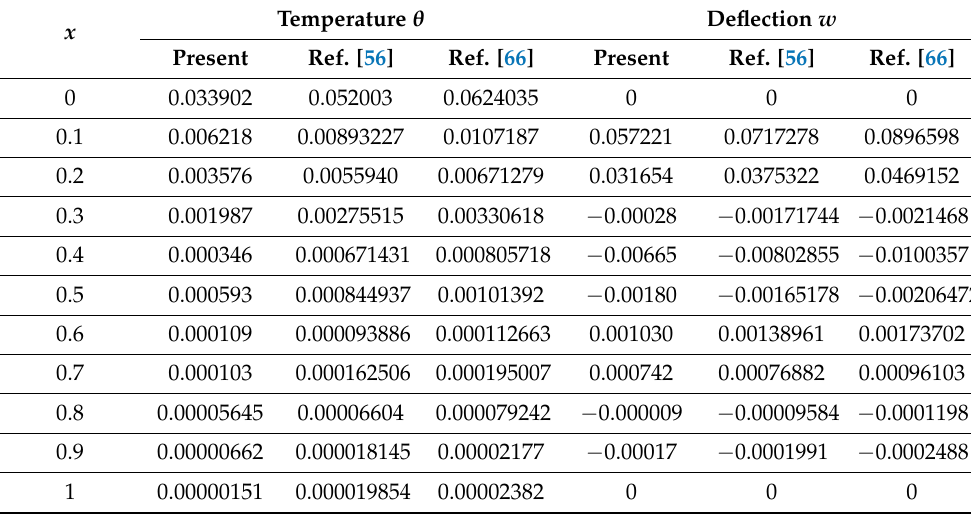
Table 2. Comparison of the temperature, θ , and deflection, w and with Refs. [56,66]. Temperature θ Deflection w x Present Ref. [56] Ref. [66] Present Ref.